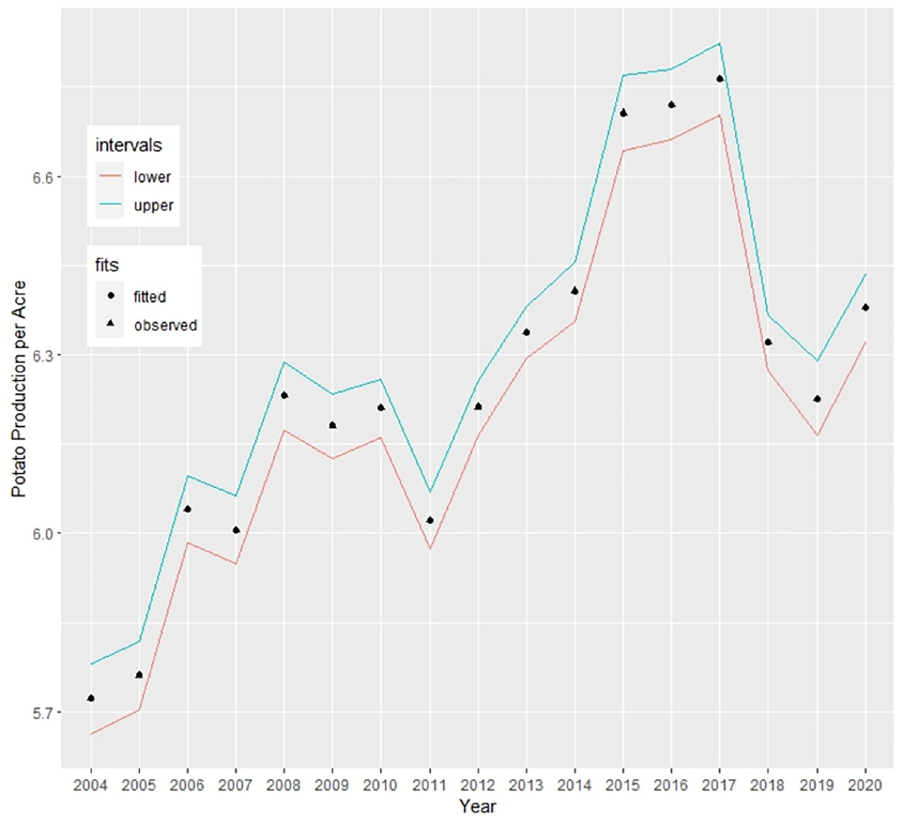
Fig 5. Time-series plot for observed and fitted potato production with 95% confidence